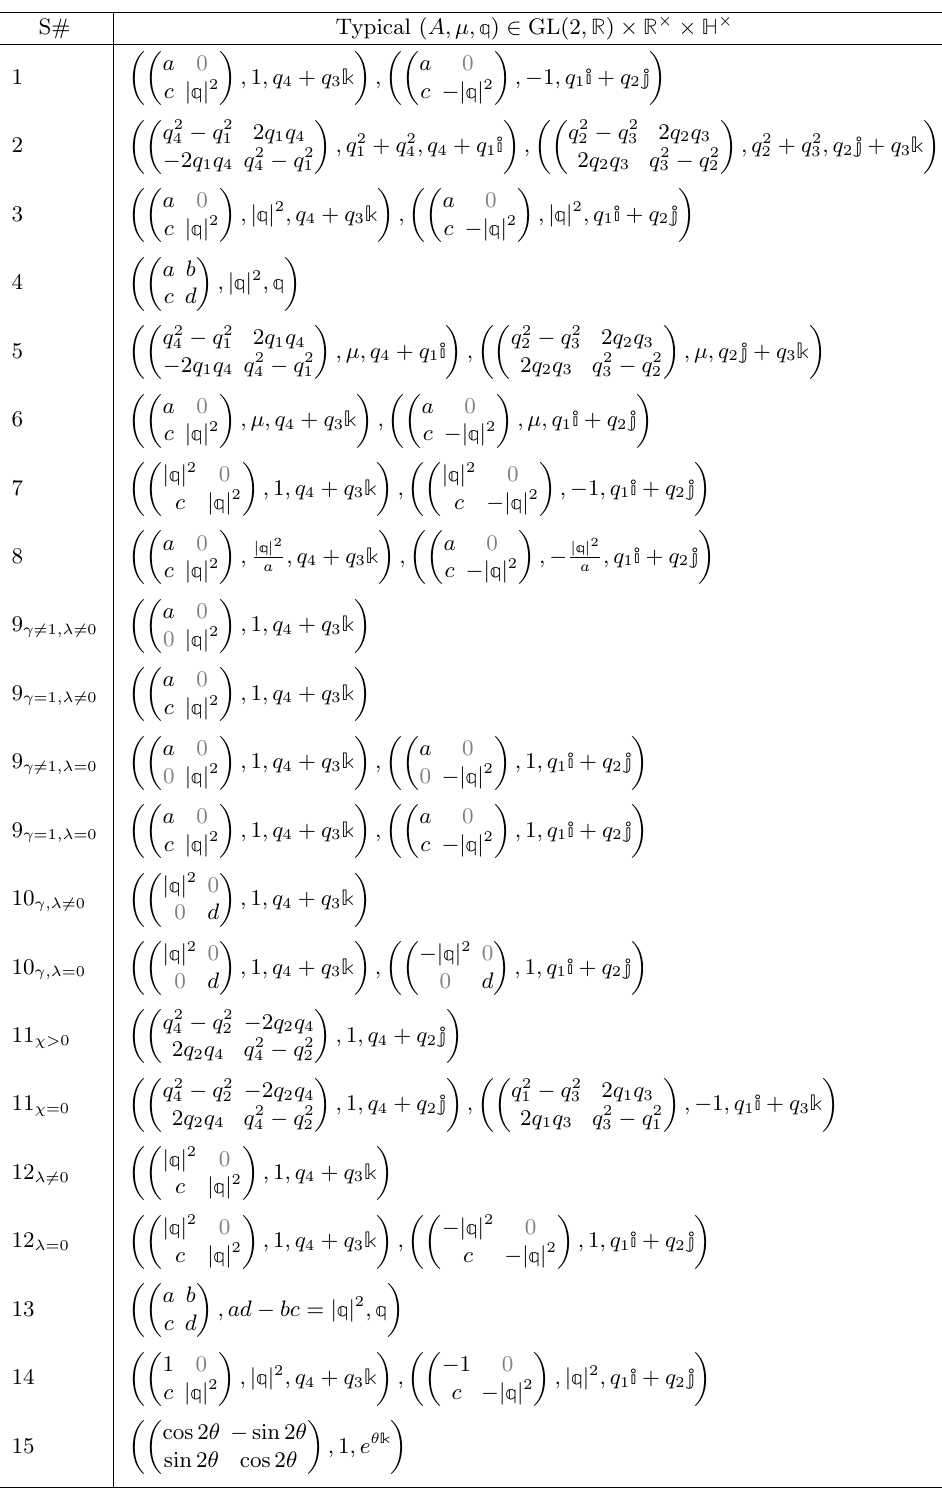
Table 8 . Automorphisms of kinematical Lie